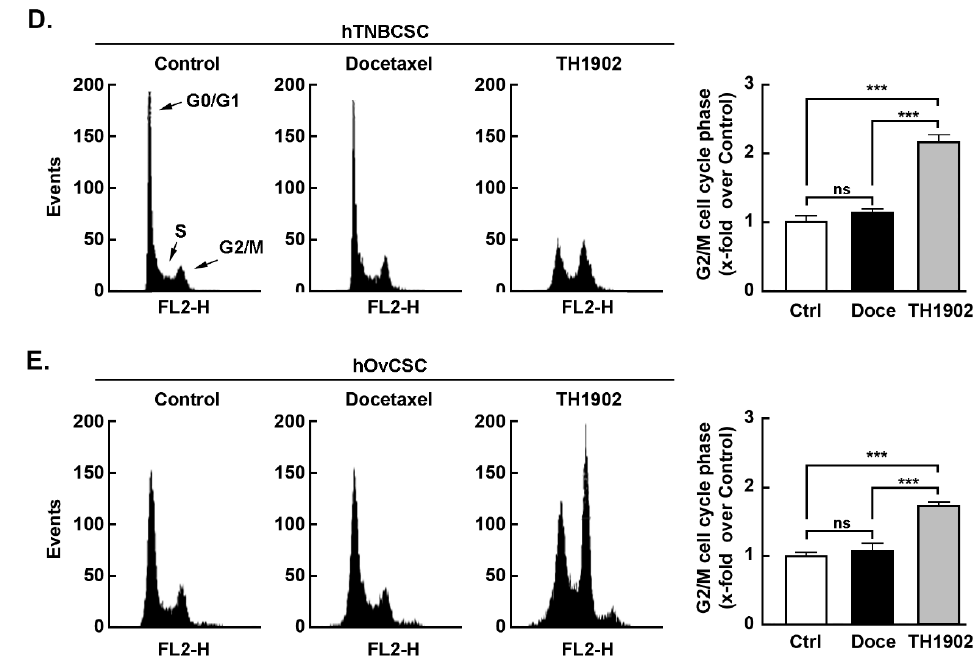
Figure 4. TH1902 induces morphological changes, apoptosis, and cell cycle arrest in hTNBCSC and hOvCSC. Cells were treated in medium containing vehicle (DMSO, Control), 4 µM docetaxel or 2 µM TH1902 for 2 h and then incubated in complete medium for 22 to 72 h. ( A ) Treated hTNBCSC were fixed and immunostained with anti- α -tubulin Ab. Cells were then stained with DAPI before imaging by confocal microscopy. Representative pictures from each condition are dis- played using fluorescence filters to demonstrate tubulin staining (green) and DAPI staining. The extent of apoptosis in ( B ) hTNBCSC or ( C ) hOvCSC was determined upon similar conditions as described above, and after different intervals of incubation ranging from 22 h to 72 h. Cells were harvested and then flow cytometry performed following staining with annexin V-FITC and propid- ium iodide (PI). Data were obtained from three different experiments and are represented as means +/ − SEM; statistical analysis was performed for each time point using one-way ANOVA with Dun- nett’s multiple comparison test (ns = non significant, * signifies p < 0.05, ** signifies p < 0.01 and *** signifies p < 0.001 for differences between TH1902 and control conditions). For cell cycling experi- ments, ( D ) hTNBCSC or ( E ) hOvCSC were treated for 2 h in medium containing vehicle (DMSO, Control), 4 µM Docetaxel or 2 µM TH1902, then incubated in complete fresh media for 22 h. The DNA content of each cell line after both intervals was analyzed by flow cytometry using FxCycle™ PI/RNase Staining Solution. The experiment was repeated 3–4 times and representative data are shown for hTNBCSC and for hOvCSC . Data are represented as means +/ − SEM. Statistical analysis was performed using one-way ANOVA with Dunnett’s multiple comparison test (ns = non signifi- cant, *** signifies p < 0.001).